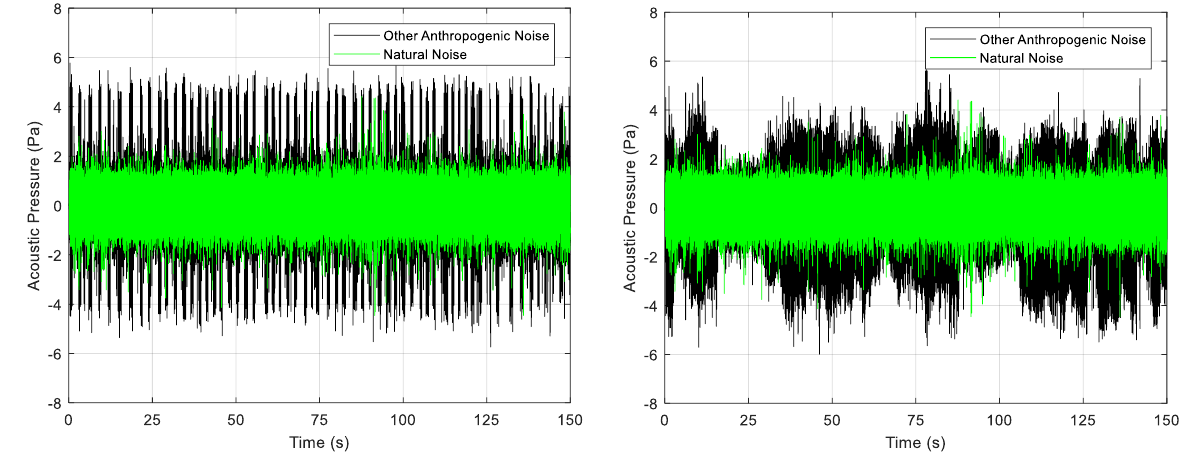
Figure 4. Time series of the amplitude (in Pa) of Other Anthropogenic Noise (black) and Natural Noise (green) measurements. Acoustic measurements performed while cleaning the hull of an anchored ship ( left ). Acoustic measurements performed while the motor of a small ship started and stopped several times near the sensor ( right ).